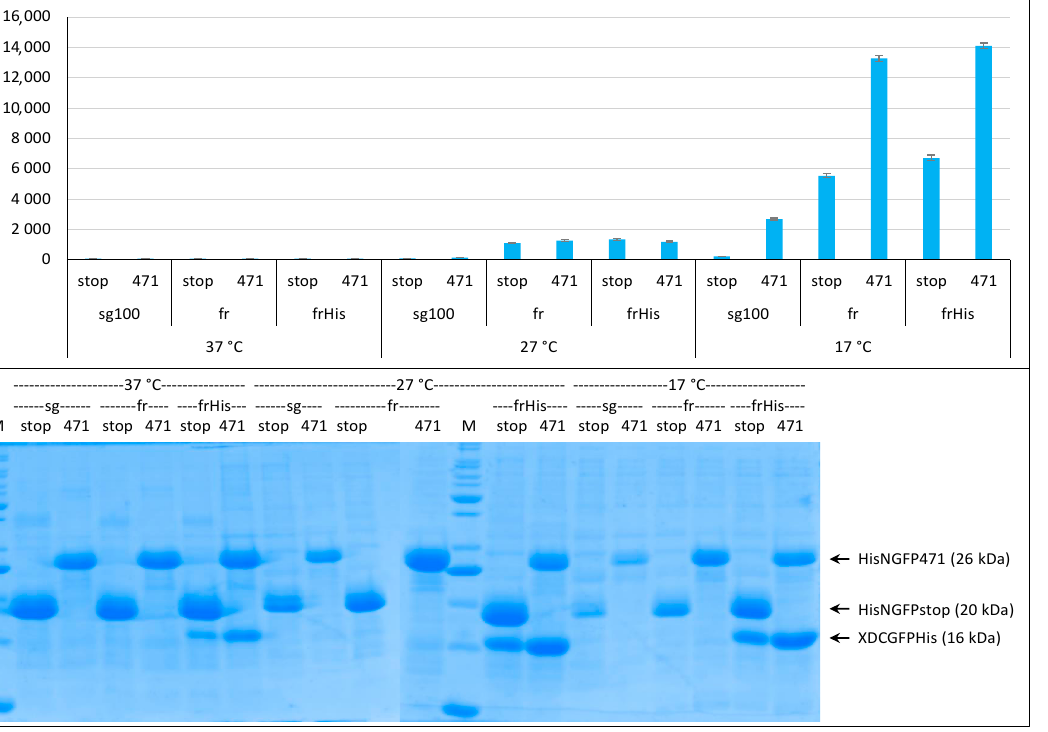
Figure 7. His-tagging CGFP fusion. Split-GFP reassembly assay results as obtained with the negative (stop) and positive (471) controls of the 417/XD interaction with sg100 and fr GFP reporters at 37 °C, 27 °C and 17 °C. In the case of fr, results obtained using His-tagged (frHis) and non-His- tagged (fr) XD-CfrGFP are shown. ( A ) Fluorescence to OD 600 ratios. ( B ) SDS-PAGE analysis of the expression of the NGFP and CGFP fusions. M, molecular size markers (200, 150, 100, 85, 70, 60, 50, 40, 30, 25, 20, 15, 10 kDa).